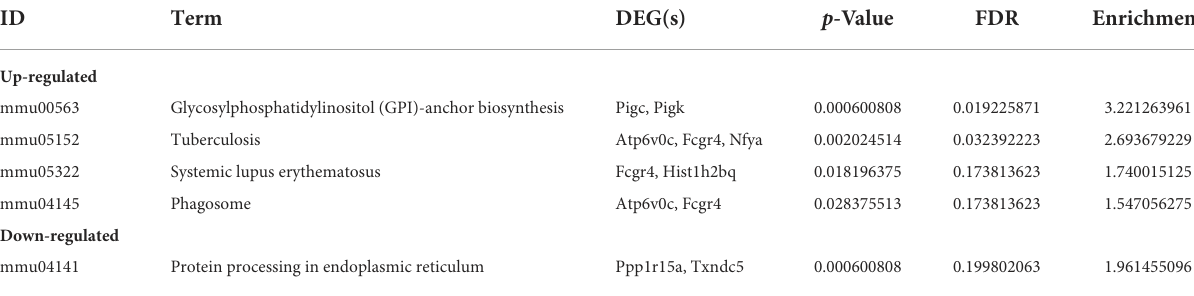
TABLE 3 Signaling pathway enrichment of up-regulated and down-regulated